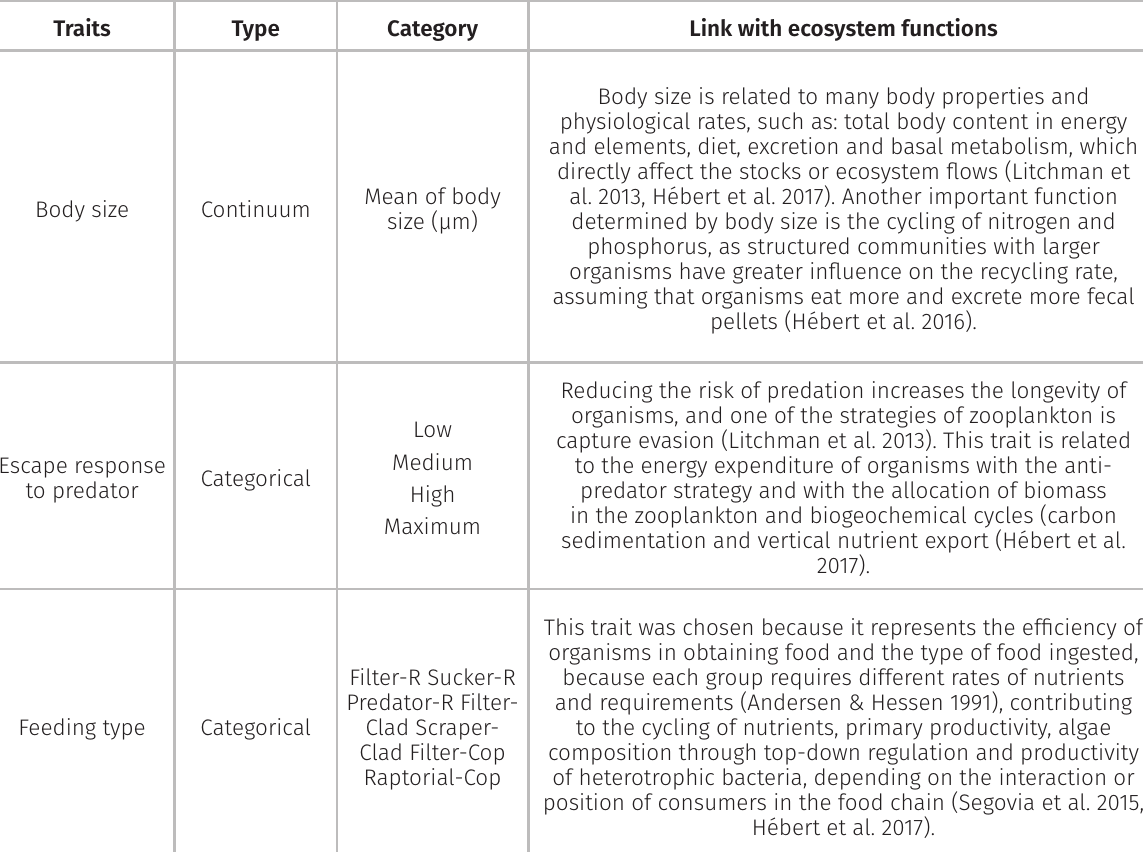
Table I. Zooplankton functional traits by type of the trait, the categories of subdivision of each trait and its ecosystemic